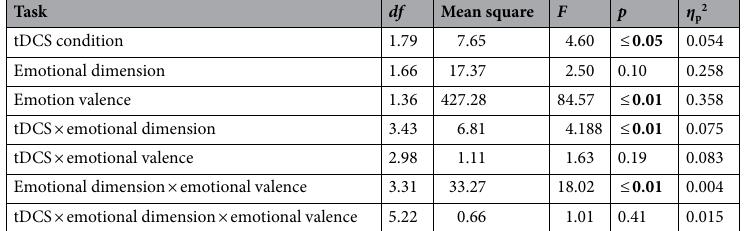
Table 3. Results of the three-way repeated-measures ANOVA for effects of tDCS conditions (anodal vmPFC/ anodal dlPFC/sham), emotional dimension (arousal, valence, dominance) and emotional valence (high, low, neutral) on emotional processing. tDCS = transcranial direct current stimulation ; vmPFC = ventromedial prefrontal cortex; dlPFC = left dorsolateral prefrontal cortex;; η p 2 = partial eta squared; Significant results are highlighted ( p ≤ 0.05) in